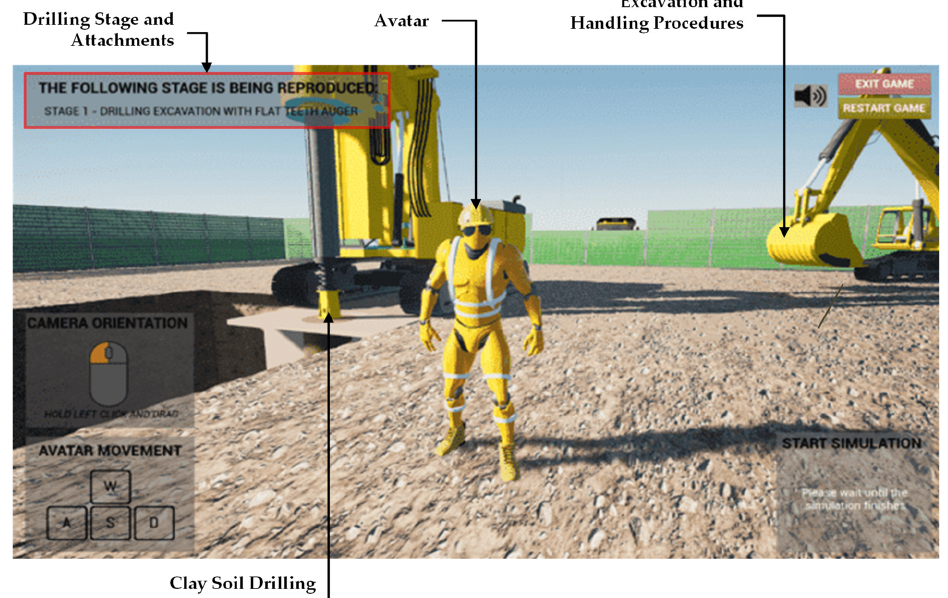
Figure 11. VR pile training module (source—Author).